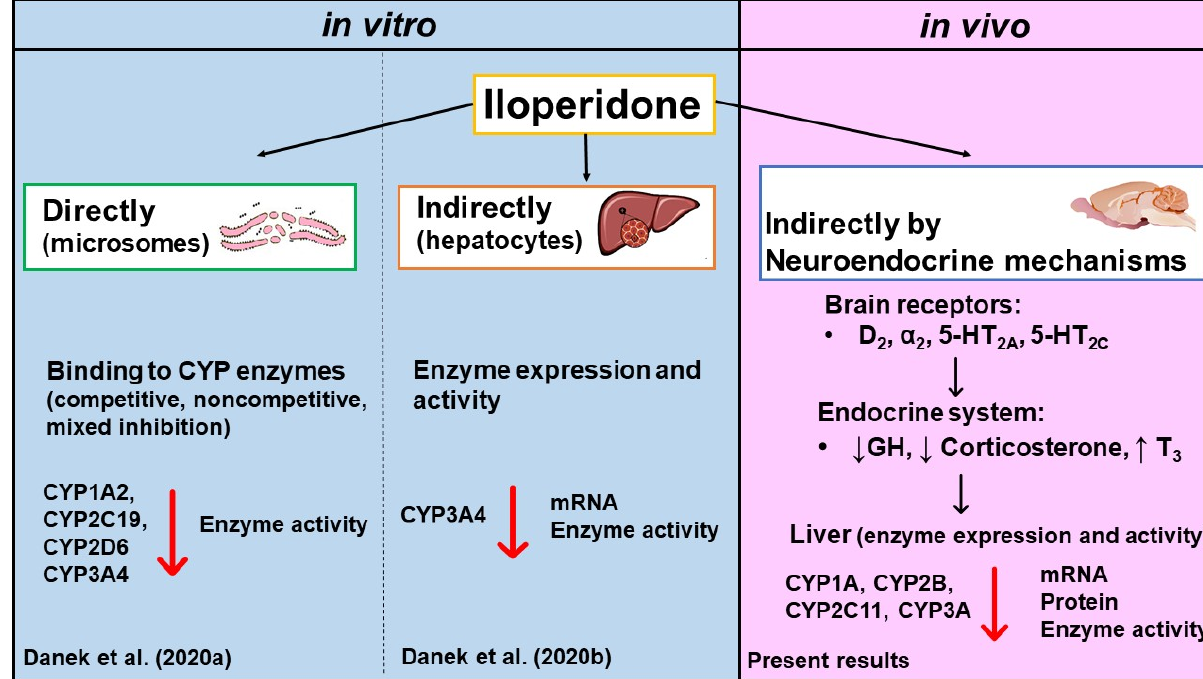
Figure 5. The effect of iloperidone on liver cytochrome P450 shown in different experimental models. The engagement of direct and indirect mechanisms in the interaction between the neuroleptic and CYP enzymes.